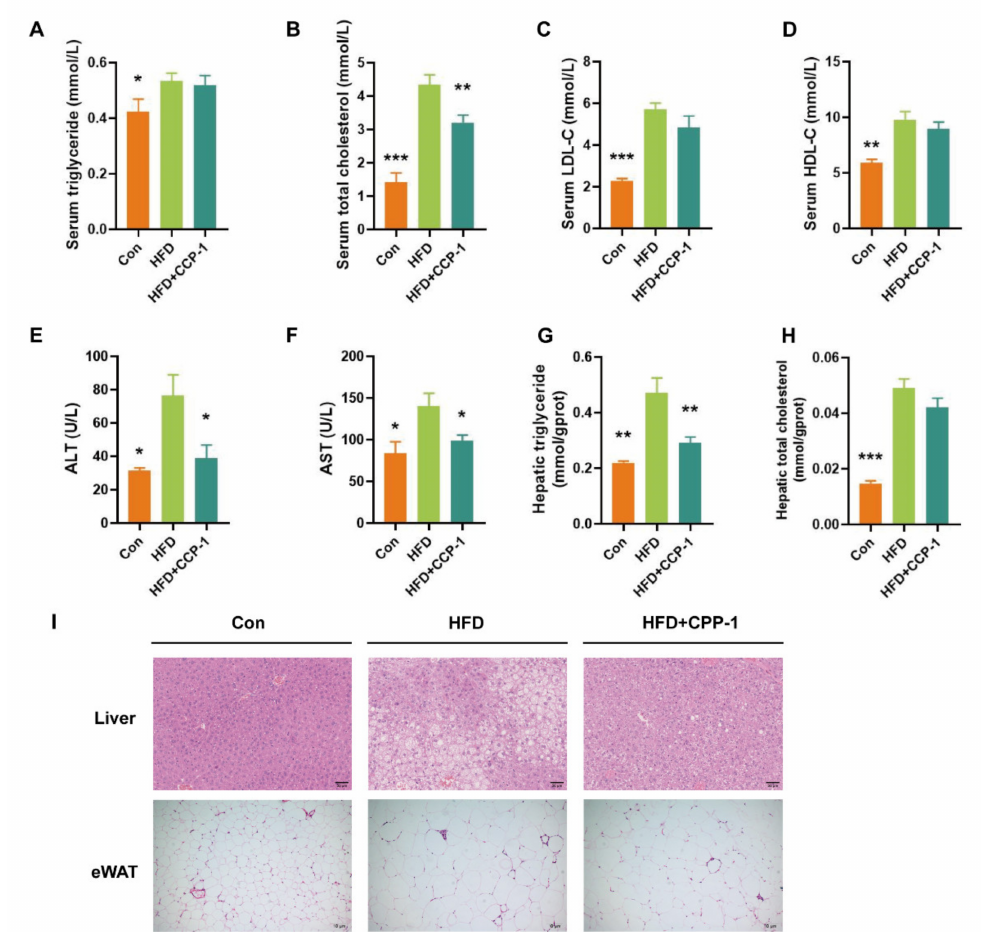
Figure 4. CPP − 1 improves lipid metabolism and alleviates lipid accumulation in mice. ( A ) Serum TG; ( B ) serum T-CHO; ( C ) serum LDL-C; ( D ) serum HDL-C; ( E ) serum ALT; ( F ) serum AST; ( G ) hepatic TG; ( H ) hepatic T-CHO; ( I ) representative H&E staining of liver, scale bar: 50 µ m (upper) and eWAT, scale bar: 10 µ m (lower) sections. Data are expressed as the mean ± SEM ( * p < 0.05, * * p < 0.01, ** * p < 0.001 versus